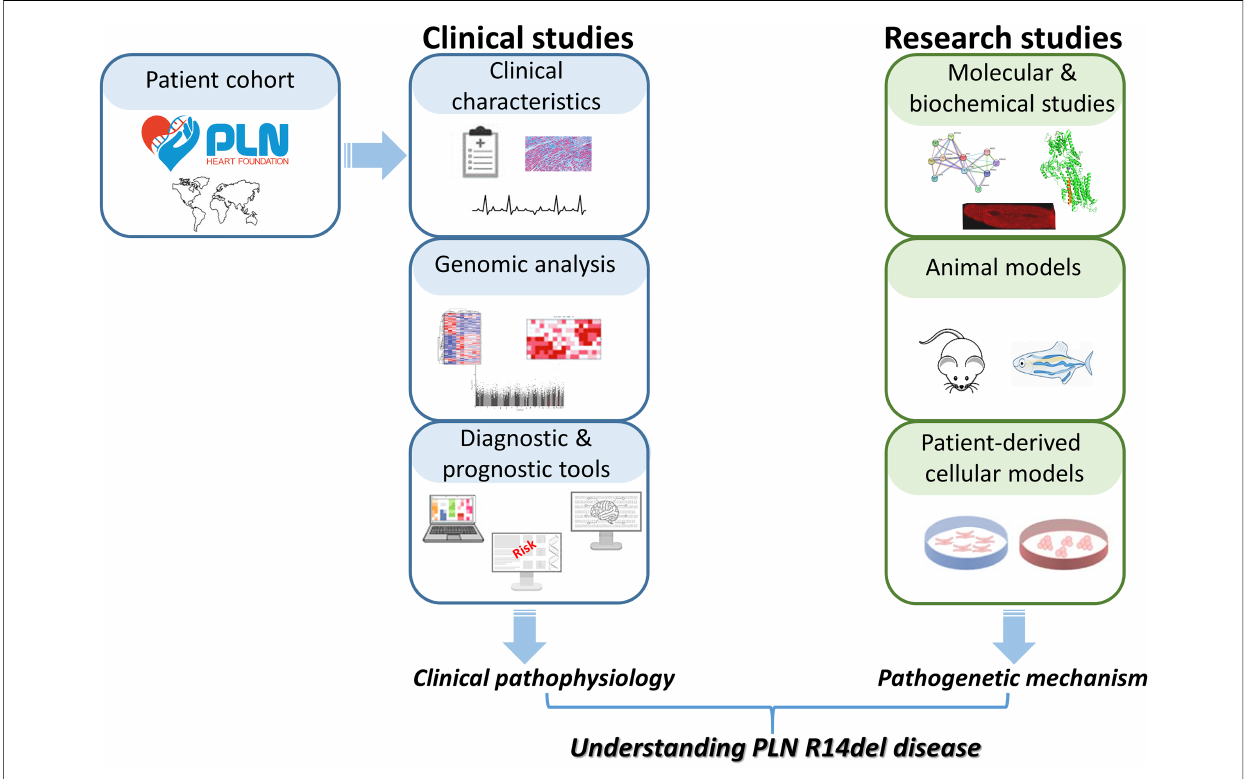
FIGURE 1 Approaches employed towards deciphering the pathophysiology of PLN-R14del disease. With the contribution of the PLN Foundation, patient communities worldwide are coming together to enable a multitude of clinical studies which have helped signi fi cantly in better de fi ning the clinical characteristics of PLN-R14del disease. In addition to this, research strategies aiming at the biochemical, molecular, cellular and animal model levels are being explored in order to decipher the pathogenetic mechanisms underlying PLN-R14del. Collectively, the increasing number of clinical and research studies have signi fi cantly enhanced our understanding of PLN-R14del